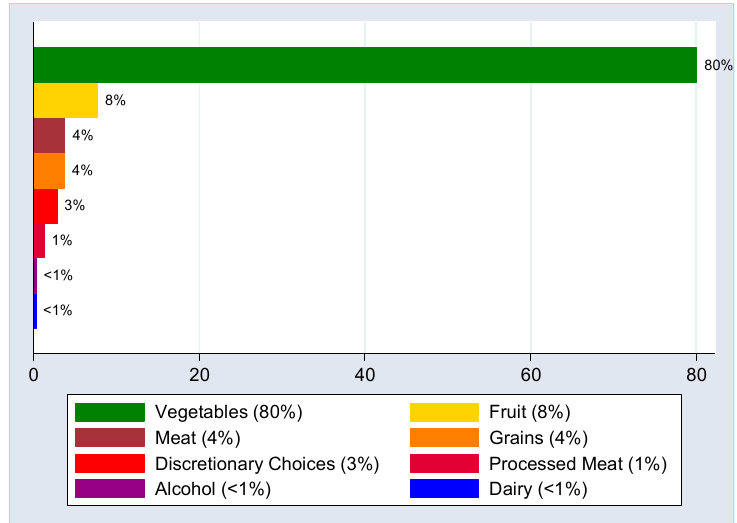
Figure 2. Percent contribution to total dietary nitrate intakes by food group. Vegetables contributed approximately 80% of total nitrate intakes, followed by fruit (8%), meat (4%), grains (4%), discretionary choices (3%), and processed meat (1%). Alcohol and dairy contributed very minor amounts of nitrate. Women reporting higher intakes of total dietary nitrate were significantly more likely to report higher dietary intakes of many dietary components, including vegetable serves, fruit serves and meat serves. Women reporting higher intakes were significantly more likely to report a higher total percent energy contributed from protein and a lower total percent energy contributed from fat, but the total percent energy contributed from carbohydrate did not differ across quartiles for total nitrate intakes (Table